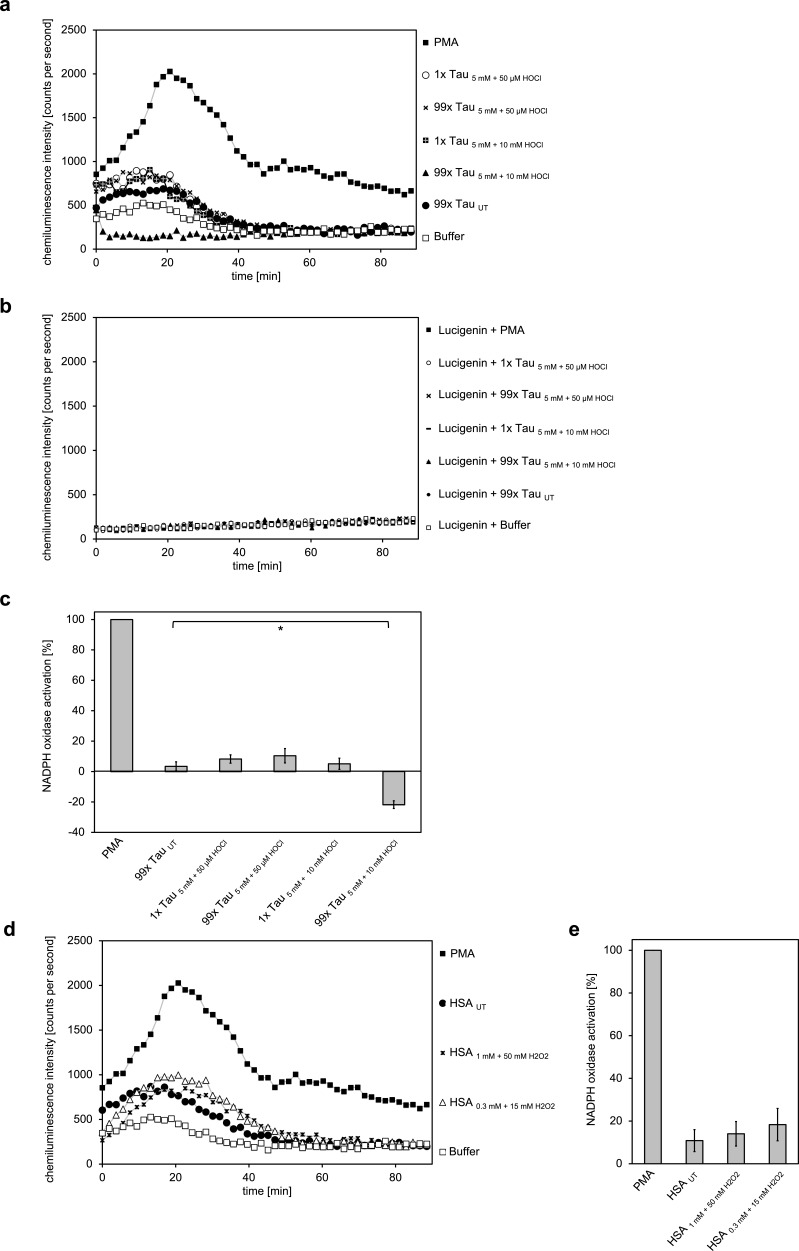
Taurine N-chloride and hydrogen peroxide-treated HSA do not induce the respiratory burst in neutrophil-like cells.(a) The model N-chloramine prepared in different ways (5 mM of taurine treated with either 50 µM or 10 mM of HOCl) at different molar excesses (1- or 99-fold the molarity of HSA used) did not lead to significant activation of the respiratory burst in differentiated PLB-985 cells. (b) Likewise, it did not have an effect on lucigenin in the absence of cells. (c) Results shown in a are expressed as integrated total counts (means and standard deviations of three independent measurements) higher (or in case of 99 x Tau 5 mM +10 mM HOCl lower) than buffer control. PMA-induced activation of NADPH-oxidase was set to 100%.
10.7554/eLife.47395.032Figure 4—figure supplement 3—source data 1.Numerical chemiluminescence plate reader data represented in Figure 4—figure supplement 3.